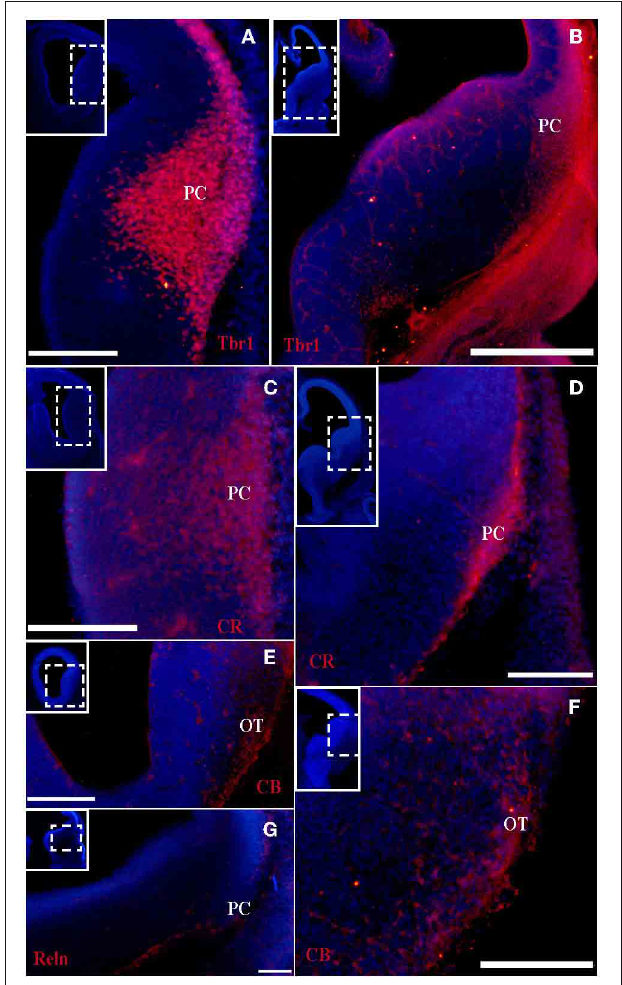
FIGURE 1 | Tbr1, CR, CB, and Reln (red) expression in the olfactory cortex at E12. (A–D) Tbr1 and CR expression in the rostral and caudal regions of the piriform cortex. (E,F) CB is expressed in the OT but not the PC. (G) Reln expression is restricted to the outermost portion of the PC. Coronal sections; midline is to the left and dorsal is up. Blue corresponds to the bisbenzimide counterstaining. Scale bars: A–F , 500 µ m ; G , 100 µ m.